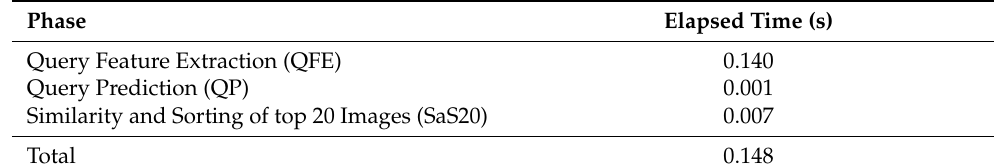
Table 1. Time spent for each phase of the retrieval process in seconds.